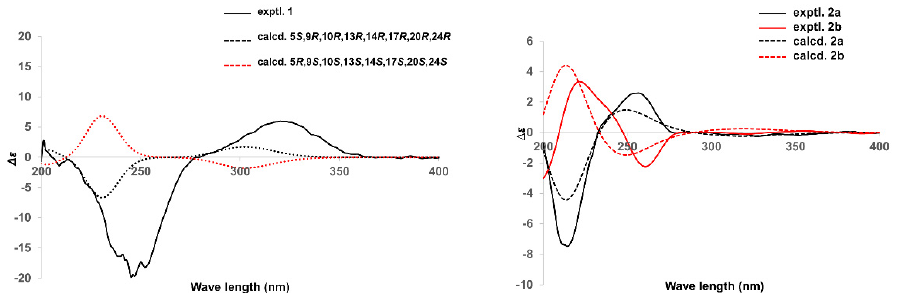
Figure 3. Experimental and calculated ECD spectra of 1 , 2a , and 2b .